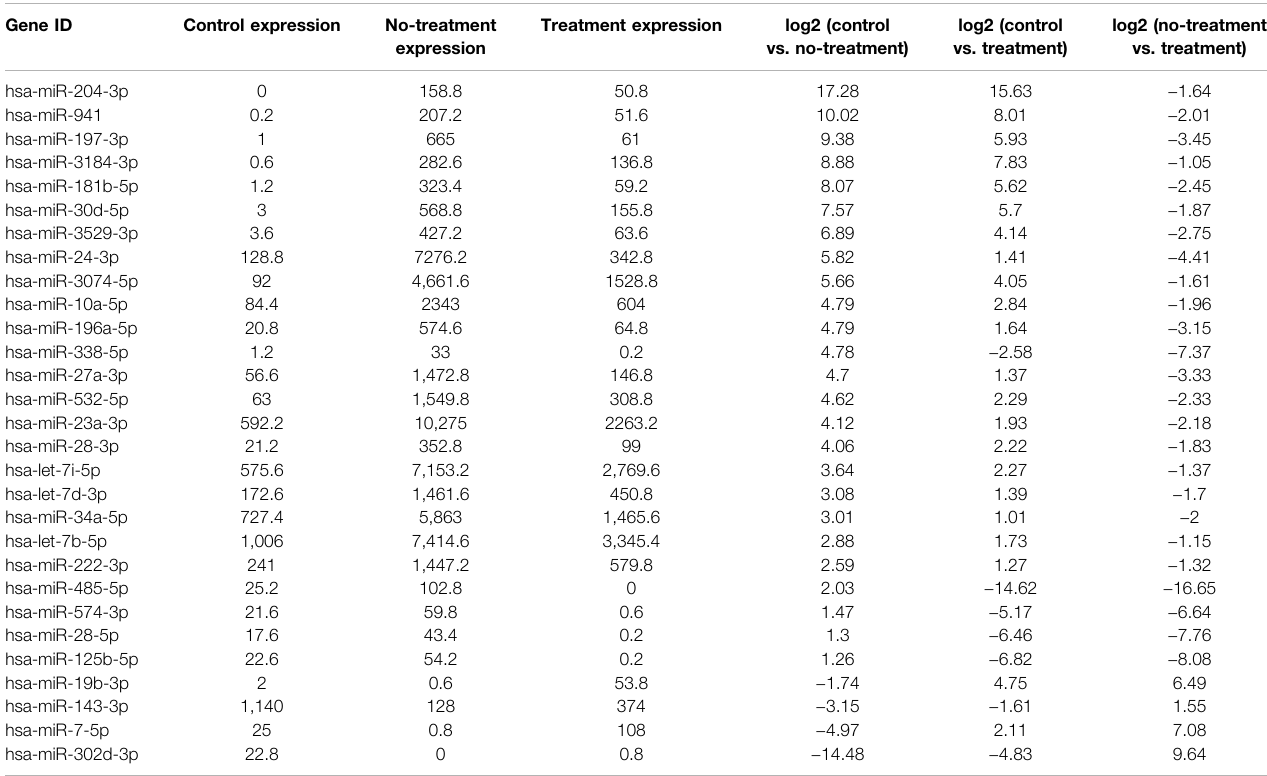
TABLE 2 | Basic information of a fl ibercept-induced miRNA pro fi le Gene